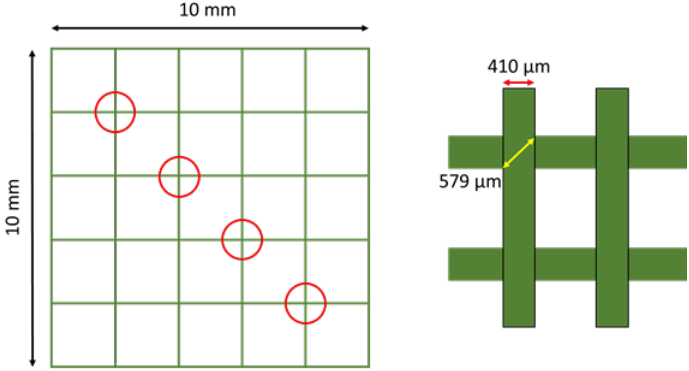
Figure 16. Schematic description of the cross-section ratio.